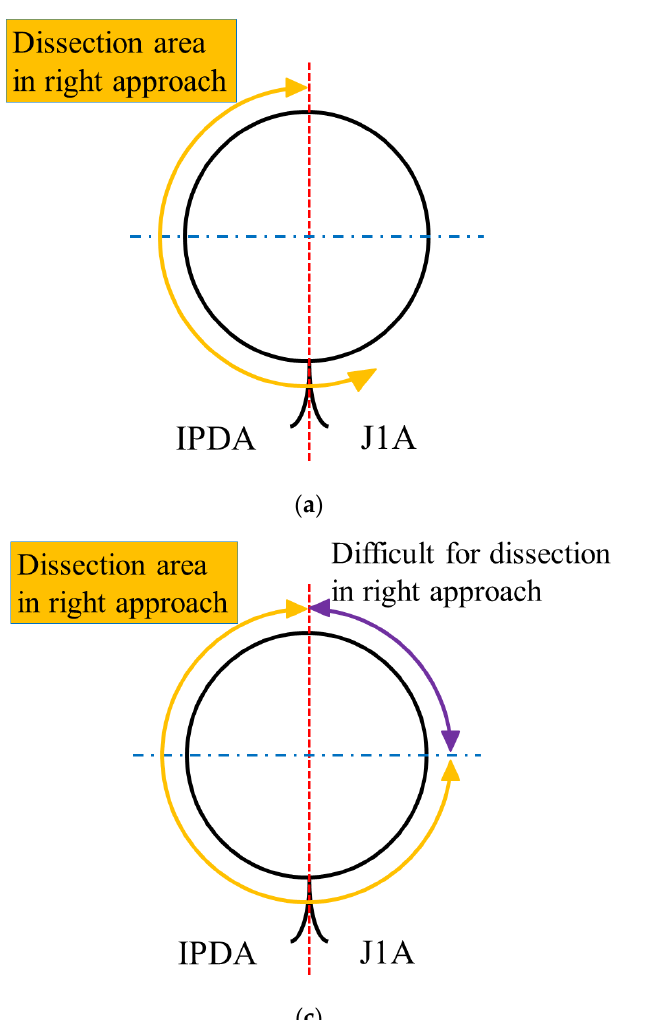
Figure 2. The anatomy around the superior mesenteric artery (SMA) during the right approach: ( a ) right approach is suitable for dissecting the right aspect of the SMA; ( b ) with the pancreatic head lifted, the axis of the SMA can be rotated clockwise approximately 90°, and the dissection area can be expanded; however, a difficult area for dissection still exists at the right side of the SMA (purple arrow); and ( c ) an overview of the dissection area around the SMA by the right approach. IPDA, inferior pancreaticoduodenal artery; J1A, first jejunal artery.